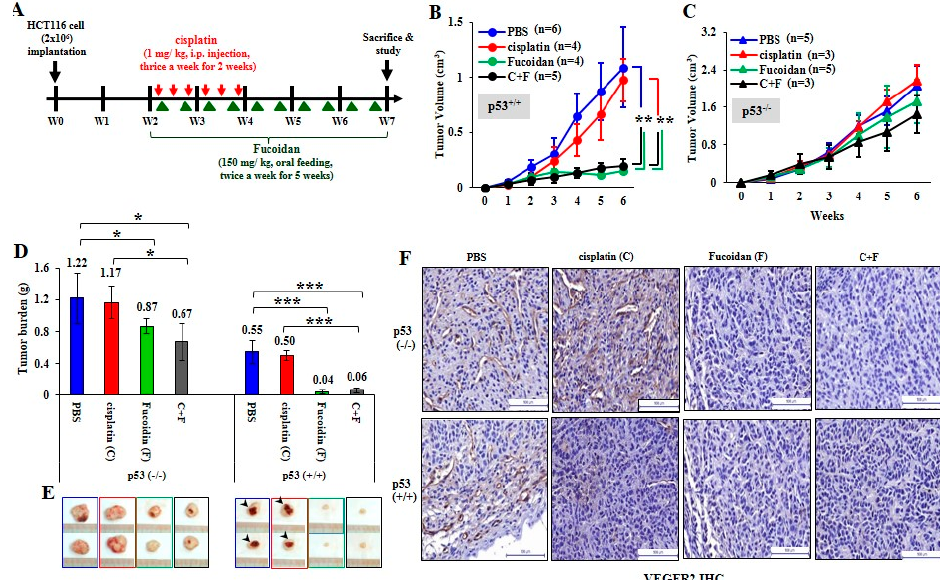
Figure 7. Oligo-Fucoidan prevents HCT116 tumor progression and angiogenesis. ( A ) HCT116 cancer cells (p53 − / − and p53 +/+ ) (2 × 10 6 ) were inoculated into nude mice and allowed tumor grow for 2 weeks, followed by treatment with cisplatin (1 mg/kg) 3 times per week for 2 weeks and/or Oligo-Fucoidan (150 mg/kg) twice per week for 5 weeks. Control experiments were treated with PBS alone. ( B,C ) The p53 − / − and p53 +/+ tumor growth rates were assessed weekly. ( D ) Tumor burdens were measured and compared between different groups at week 7. ( E ) Representative photographs of p53 − / − tumors and p53 +/+ tumors show the therapeutic outcomes. ( F ) Immunohistochemistry examined VEGFR2 ( + ) angiogenesis in the p53 − / − and p53 +/+ tumors after the indicated treatment. The results are expressed as the mean ± SD. Student’s t test determined the statistical significance of pairwise comparisons (* p < 0.05; ** p < 0.01; and *** p <